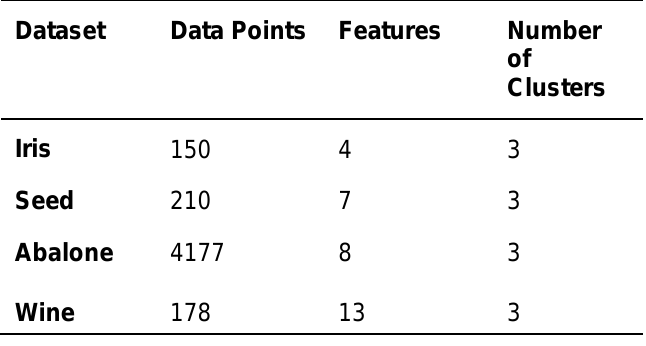
Table 2. Brief Information of UCI